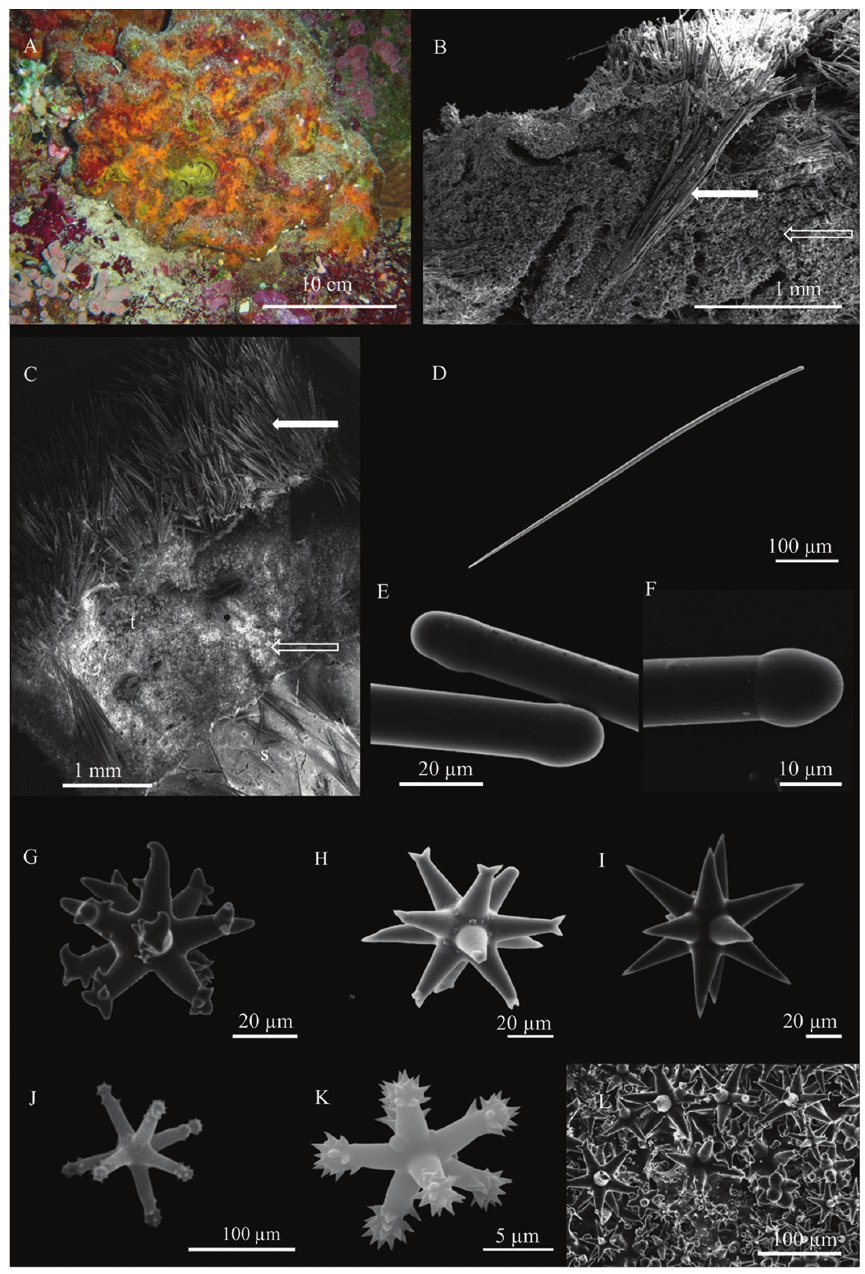
Figure 3. Tethytimea tylota (Hentschel, 1912) A specimen in situ (BU-562) B cross section showing bundles of big tylostyles (full arrow) and the microscleres (empty arrow) C SEM image showing fans of small tylostyles (full arrow) and microscleres (empty arrow) of T. tylota ( t ), below the sponge Stelletta sp. n. ( s ) involved in the association D small tylostyle E, F heads of tylostyles G–I oxyspherasters J, K ty- lasters L groups of